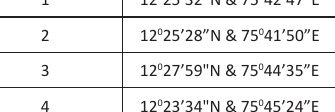
Table 2. GPS locations of the five sacred groves (control Sacred grove no.